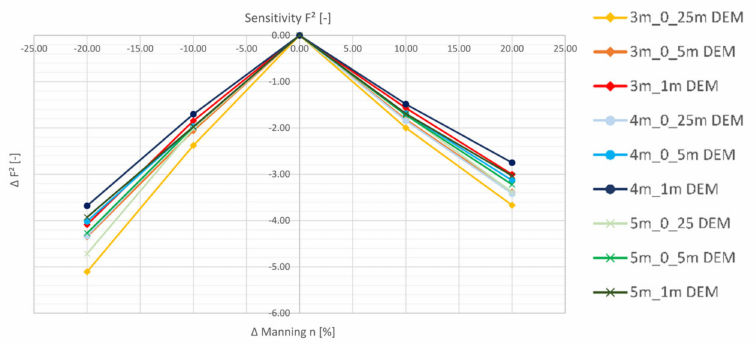
Figure 30. Comparison of the model sensitivity (S-F 2 ) for Manning’s n values and the evaluated mesh and DEM